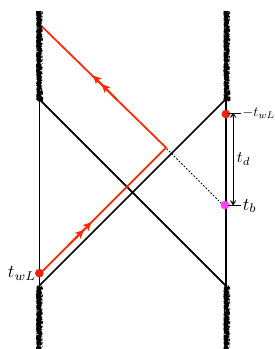
Figure 3 . An observer on the right can meet the charged shell only if they fall in before time t b